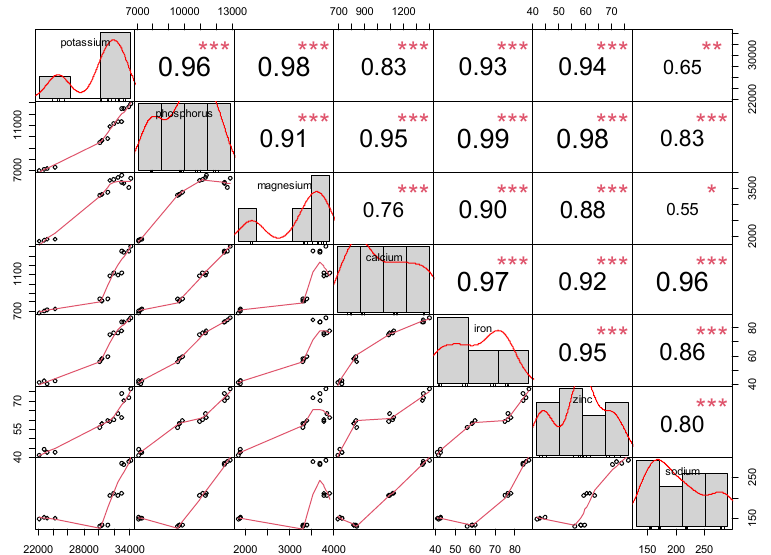
Figure 2. Correlation matrix of macro- and micro-element yields (mg kg − 1 × yield t ha − 1 ). Note: *** ( p < 0.001), ** ( p < 0.01), * ( p <